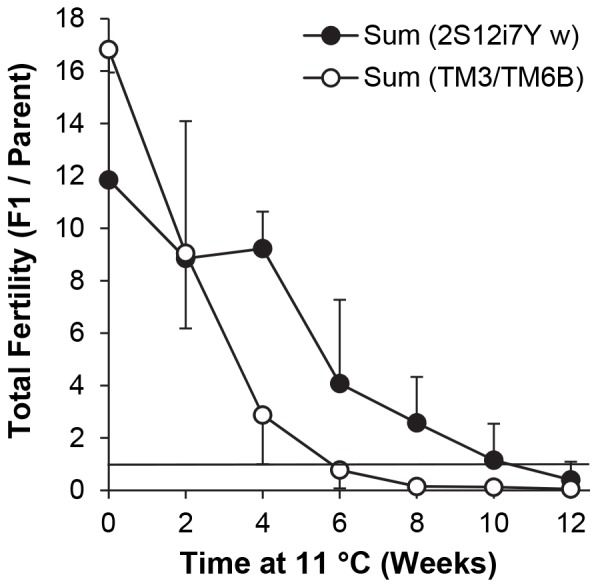
Fertility of adult flies from less fertile stocks after recovery from incubation at 11°C.Groups of 5 female and 5 male flies were crossed 1–3 d after eclosion and placed immediately at 11°C for 0–12 weeks. Flies were then provided with fresh vials for 3 successive broods at 25°C, each of 6 d duration. Results (mean ± S.D.) are sums of adult F1 progeny per original parental fly (total progeny divided by 10) from all 3 broods. n = 4 vials per time point (except for 2S12i7Y w at 12 weeks, n = 3). Filled circles: 2S12i7Y w. Open circles: TM3, ry
RK
Sb
1
Ser
1/TM6B, Tb
1. The horizontal bar represents the threshold for stock replacement, i.e. 1.0 fully eclosed F1 adult per parental fly after 18 d.